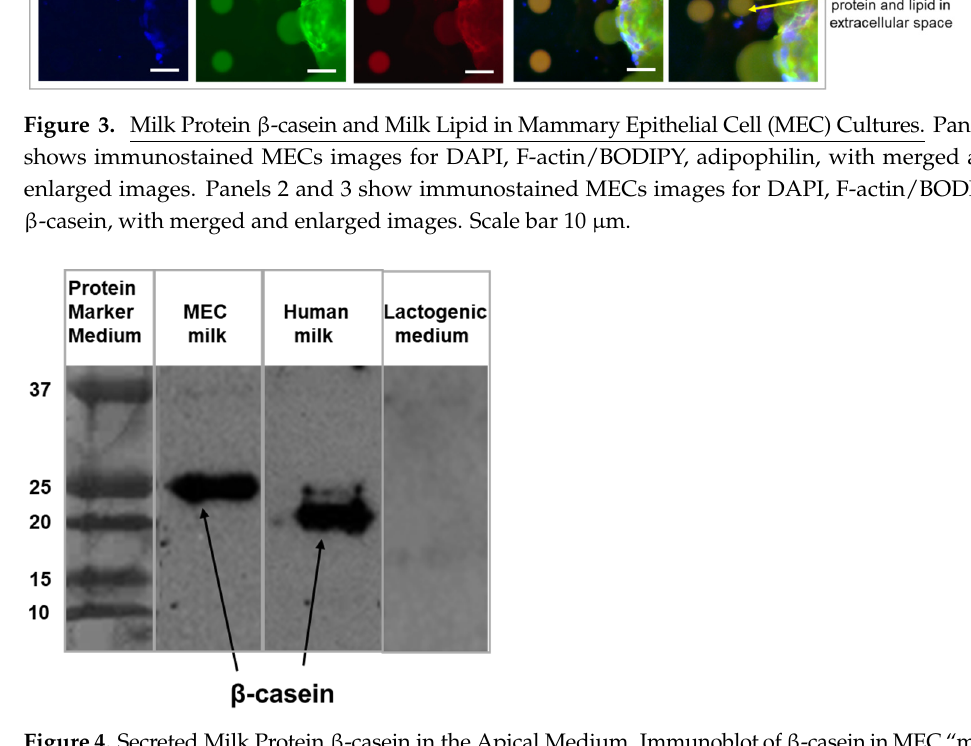
Figure 4. Secreted Milk Protein β -casein in the Apical Medium. Immunoblot of β -casein in MEC “milk” (mouse 25 kDa), human milk as a positive control (23 kDa), and lactogenic medium (no band detected).